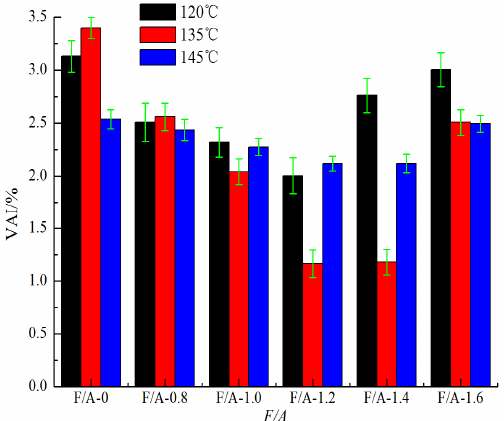
Figure 7. Value of base asphalt mortar.